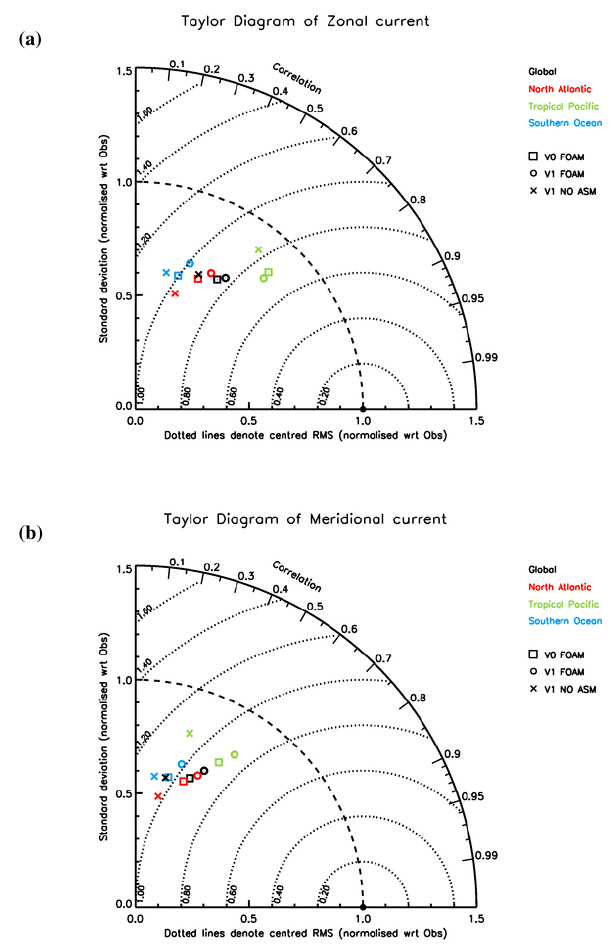
Fig. 6. Taylor plots of the global drifter current validation to show Figure 6: Taylor plots of the global drifter current validation to show the benefit of running with data assimilation and the impact of the FOAM V1 changes for (a) zonal the benefit of running with data assimilation and the impact of the current and (b) meridional current. Each plot contains comparisons between the FOAM V1 changes for (a) zonal current and (b) meridional current. FOAM V1 hindcast run (circles), the FOAM V1 non-assimilative hindcast run Each plot contains comparisons between the FOAM V1 hindcast (crosses) and the FOAM V0 hindcast run (squares) each for a subset of the regions run (circles), the FOAM V1 non-assimilative hindcast run (crosses) presented in Table 2 – namely Global (black), North Atlantic (red), Tropical Pacific and the FOAM V0 hindcast run (squares), each for a subset of the (green) and Southern Ocean (blue). regions presented in Table 2 – namely Global (black), North At- lantic (red), tropical Pacific (green) and Southern Ocean